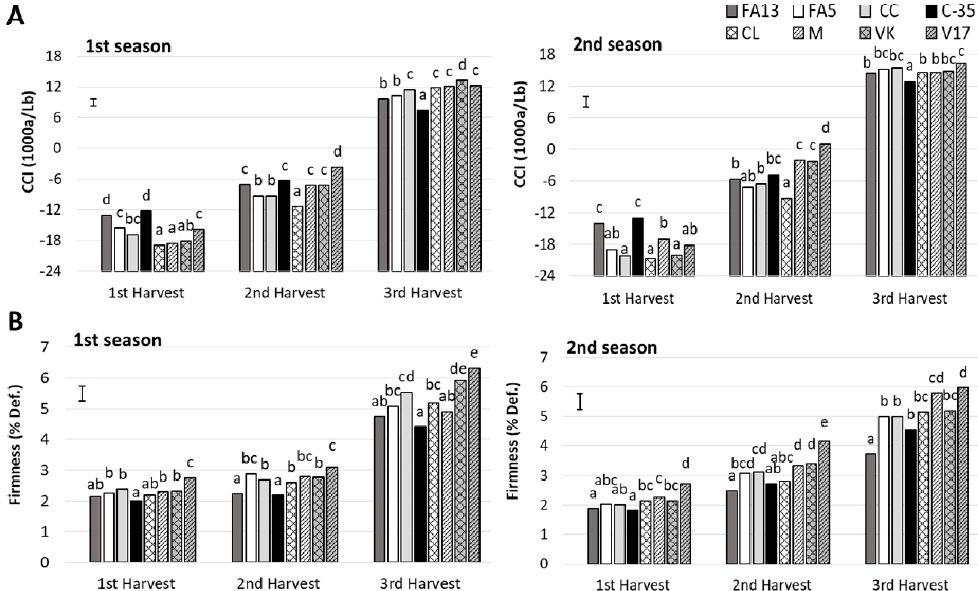
Figure 1. Citrus color index (CCI) ( A ) and firmness ( B ) of the ‘Clemenules’ mandarin grafted onto the eight studied rootstocks at three harvest times during two seasons. Vertical bar in each season represents the least significant difference (LSD) intervals ( p ≤ 0.05) (interaction harvest-rootstock). Different letters above bars indicate significant differences among rootstocks at each harvest time ( p ≤ 0.05).